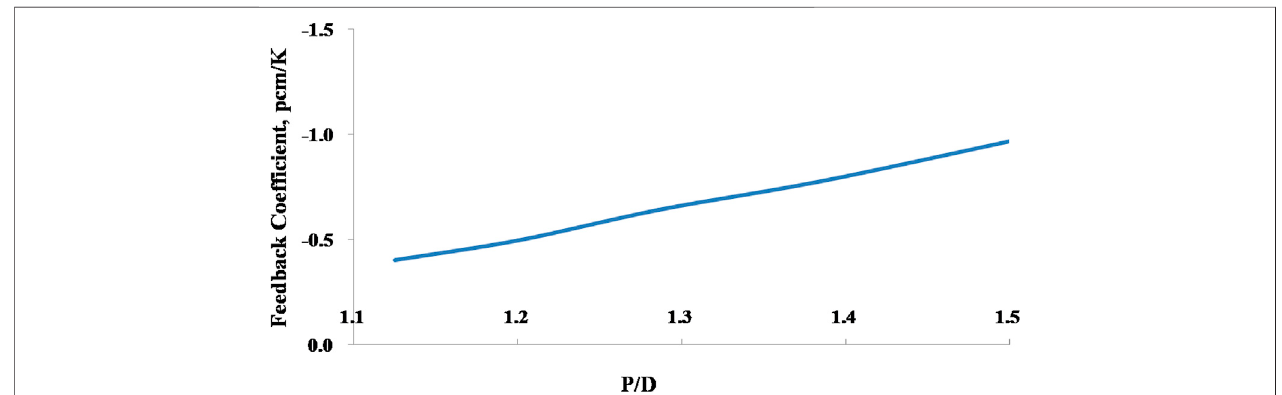
FIGURE 8 | Coolant temperature feedback coef fi cient versus P/D.